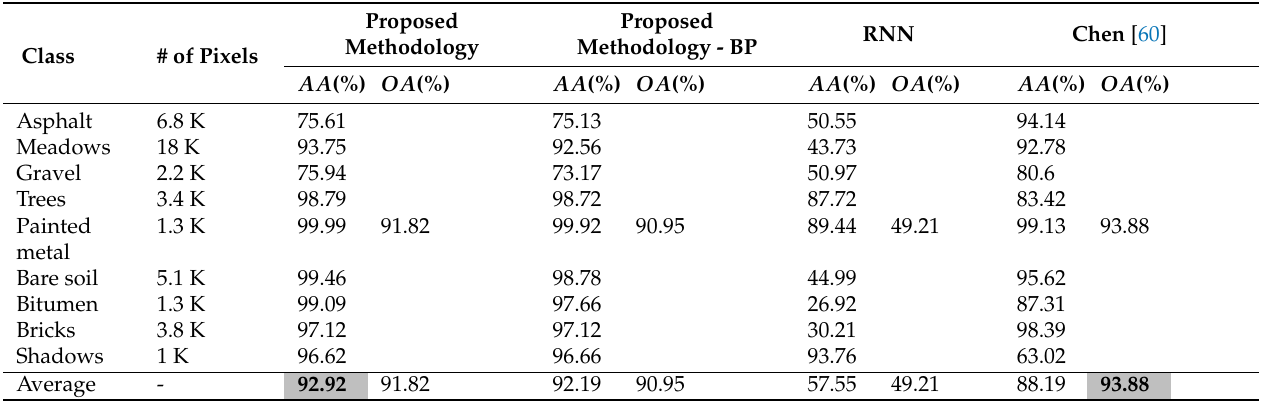
Table 9. Comparison results of the proposed methodology for the Pavia database. The best average values achieved by each method are